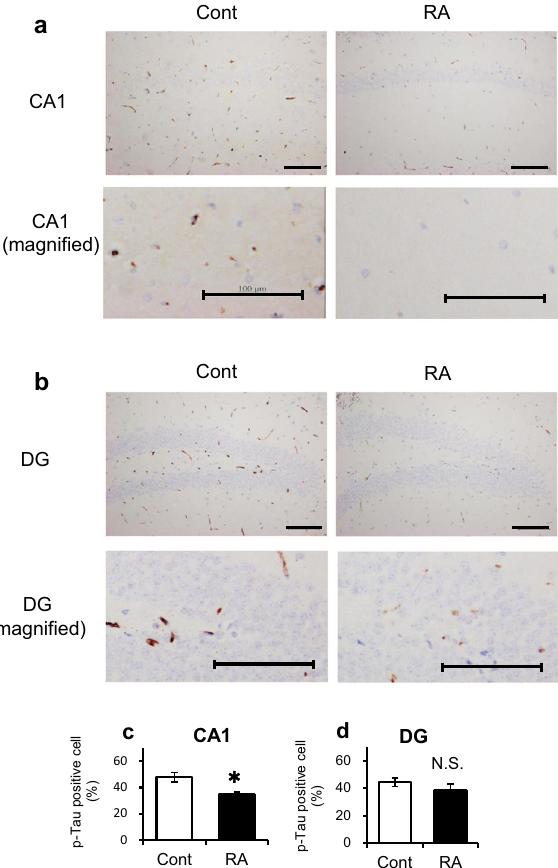
Fig. 3 Suppression of p-tau in Alzheimer ’ s disease pathology by RA intake. Paraf fi n sections were stained with anti-p-tau (AT8) and peroxidase-based labeling (brown) and counterstained with hema- toxylin to visualize nuclei (violet). Immunohistochemistry for p-tau in the CA1 ( a ) and DG ( b ) regions of the hippocampus. The scale bar showed 100 μ m in distance. c – d Percentage of p-tau-positive cells in CA1 ( c ) and DG ( d ). Bregma, − 1.8 to − 2.2 mm; slice thickness, 5 μ m Data are shown as means ± standard error. Cont, n = 3; RA, n = 3, * p <